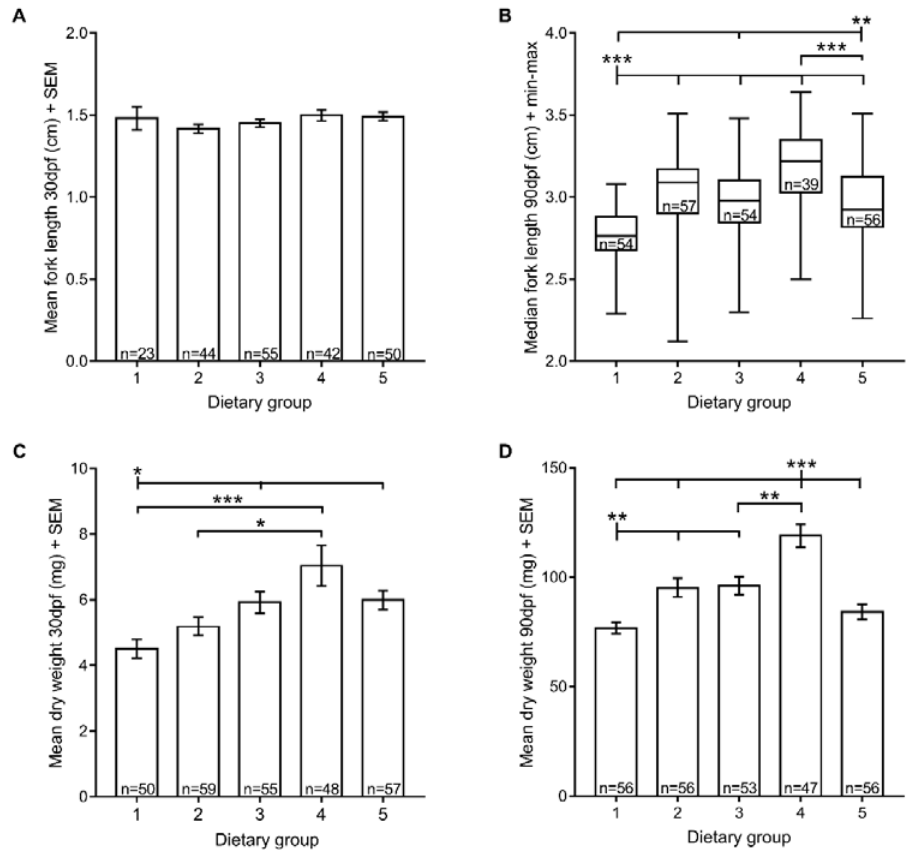
Figure 2. Zebrafish growth (size and weight) under five different feeding regimens. ( A ) Mean fork length at 30 dpf; ( B ) median fork length at 90 dpf; ( C ) mean dry weight at 30 dpf; ( D ) mean dry weight at 90 dpf. Statistically significant differences in size and weight are depicted: * p < 0.05, ** p < 0.01, *** p < 0.001. Group 1, Zeb. + Rot. <60 dpf, Zeb. >60 dpf; Group 2, Gem. + Rot. <60 dpf, Gem. >60 dpf; Group 3, Zeb. + Rot. <15 dpf, Zeb. >15 dpf; Group 4, Gem. + Rot. <15 dpf, Gem. >15 dpf; Group 5, Gem. + Rot. <60 dpf, Zeb. >60 dpf (Zeb = Zebrafeed ® ; Gem = GemmaMicro ® ; Rot = rotifers).